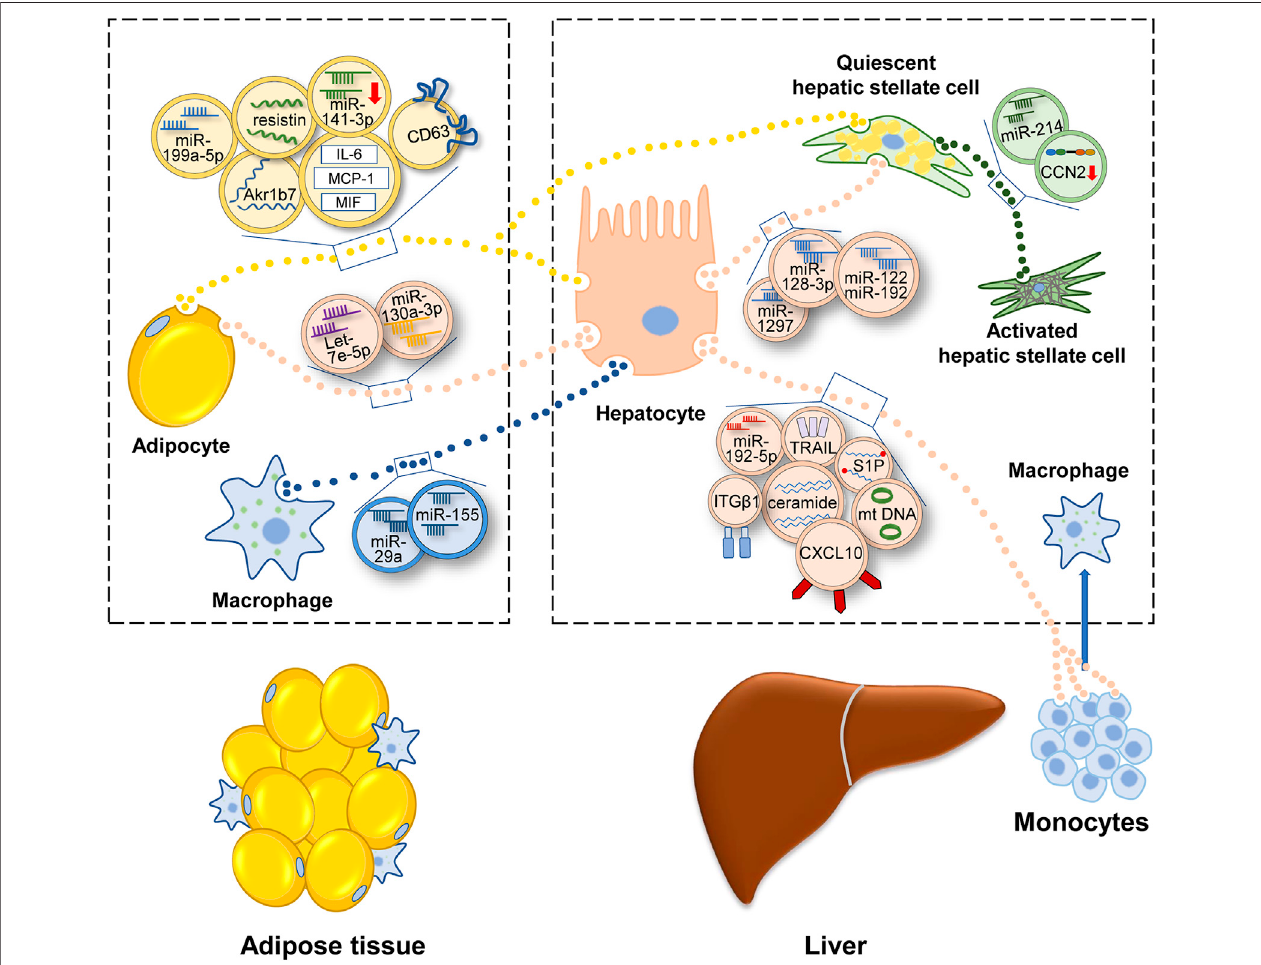
FIGURE 3 | Illustration for how EVs participate in the development of MAFLD. Under the condition of metabolic disturbance, cells secrete EVs to transfer information, which contain protein, lipid, miRNA, lncRNA or DNA. Adipocytes and macrophages in adipose tissue transfer EVs to liver and regulate the lipid metabolism and fi broticphenotypeinliver.Insideliver,EVslinkupthecommunicationofvarioushepaticcellsandpromoteMAFLDprogression.EVssecretedoutsidethelivercanbe consumedbyadipocytesandmonocytes,thenregulatingenergymetabolismandin fl ammatorycondition.Abbreviation:aldo-keto-reductase1B7(Akr1b7),cluster of differentiation 36 (CD36), interleukin-6 (IL-6), monocyte chemoattractant protein-1 (MCP-1), migration inhibitory factor (MIF),connective tissue growth factor (CCN2), mitochondrialDNA(mtDNA),sphingosine-1-phosphate(S1P),tumornecrosisfactor-relatedapoptosis-inducingligand(TRAIL),integrin β 1(ITG β 1),C-X-Cmotifligand10